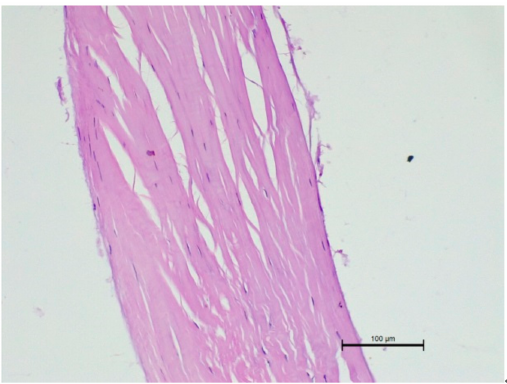
Figure 7. Microscopic examination of a ruptured chorda tendinea from a dog. A severe disarrange- ment of filaments is visible. HE stain; magnification 200 × . Valve side is at the bottom of Figure, while the papillary muscle part is at the top.